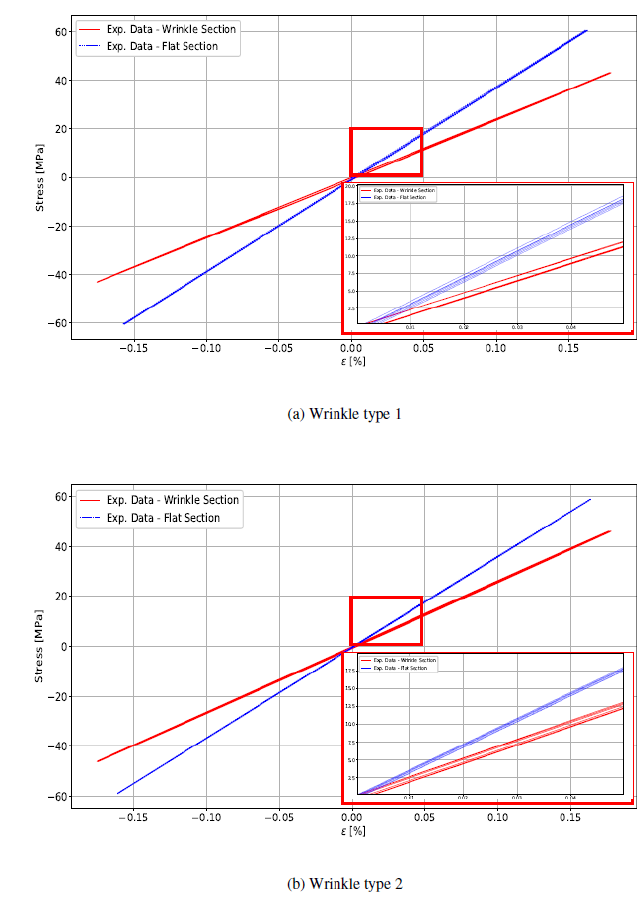
Figure 9. Stress vs. strain graph of wrinkle specimens type 1 (a) and type 2 (b) with average strain between top and bottom. The strain is measured over 50mm around the wrinkle section and 25mm around the flat section (see Figs. 7 and 8) with local zoom showing the hysteresis loop of the elapsed cycles.